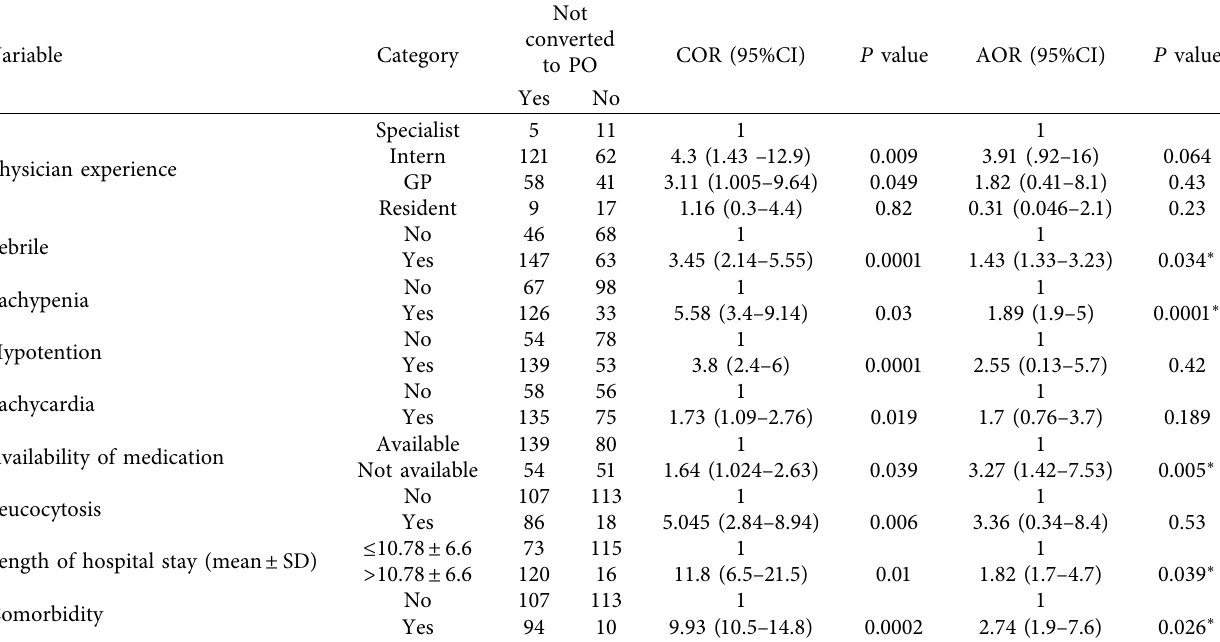
Table 3: Logistic regression analysis of antibiotics conversion practice at UOGCSH ( n �